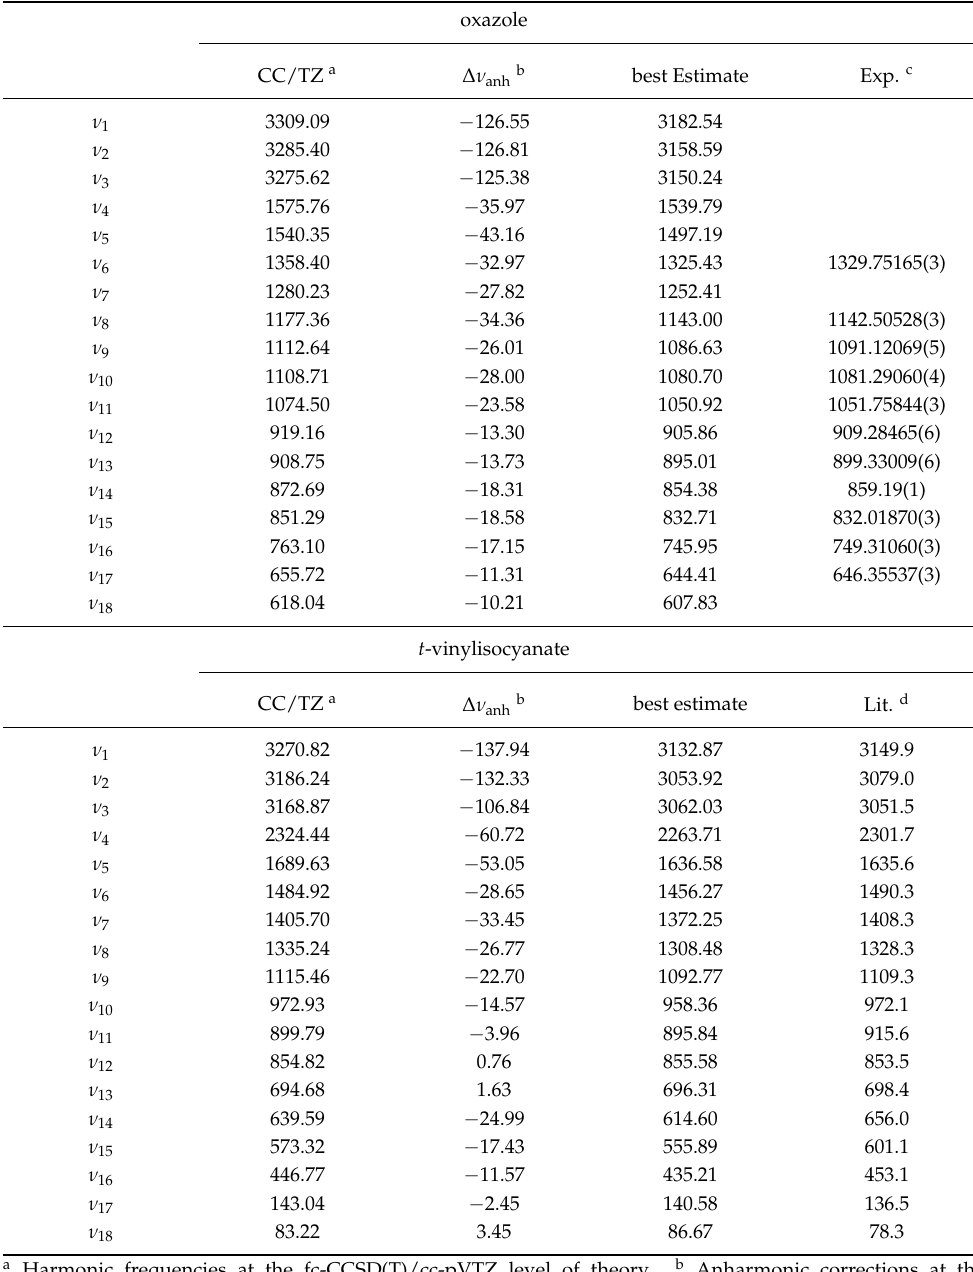
Table 3. Computed vibrational frequencies of oxazole and t -vinylisocyanate compared to the available experimental values. All values are in cm − 1